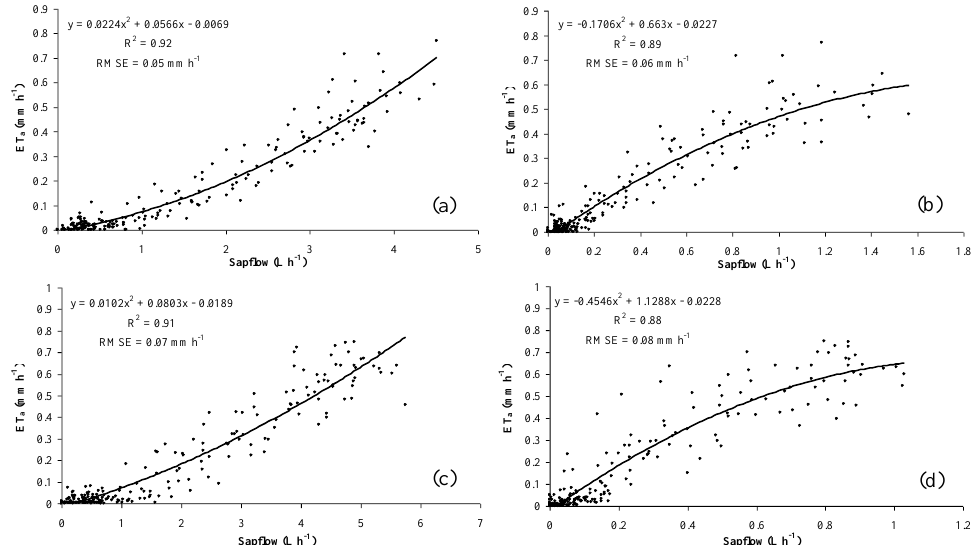
Figure 9. Polynomial regressions of actual total evaporation (ET a ) against the hourly sap flow for the (a) emergent and (b) understory trees during November 2009, and the (c) emergent and (d) understory trees in March 2010.